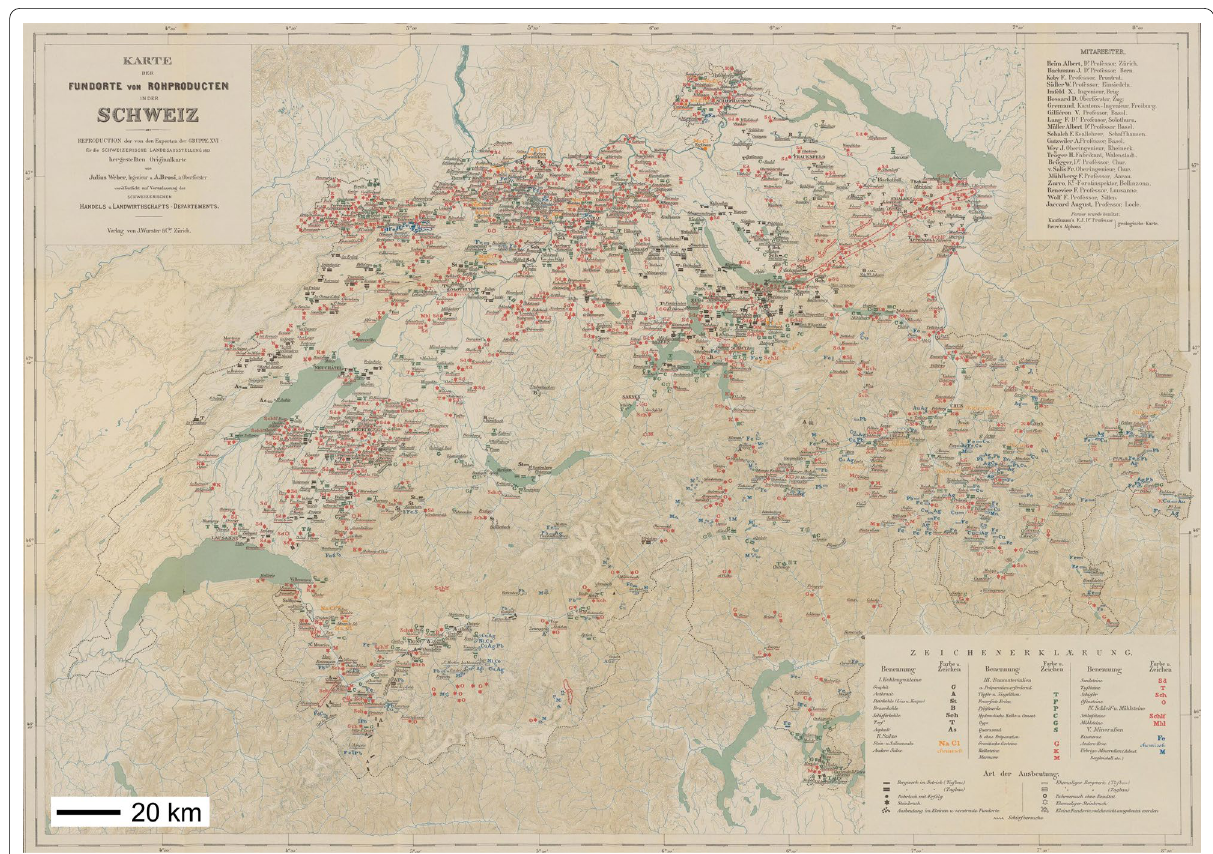
Fig. 4 Georesources map of Switzerland (1:500 ′ 000) by Weber and Brosi (1883). This map was presented at the first national exhibition 1883 in Zurich and represents the first compilation of this kind at the Switzerland scale. In order to get an overview on the areas that were explored the most, the map is shown here in its full extent. Details are not readable at that map scale. A high resolution version of this map is available here: https:// www.e- rara. ch/ zuz/ doi/ 10. 3931/e- rara- 31156. Explanation of the symbols’ colours: black : coal, peat, asphalt; yellow : salt, dark green